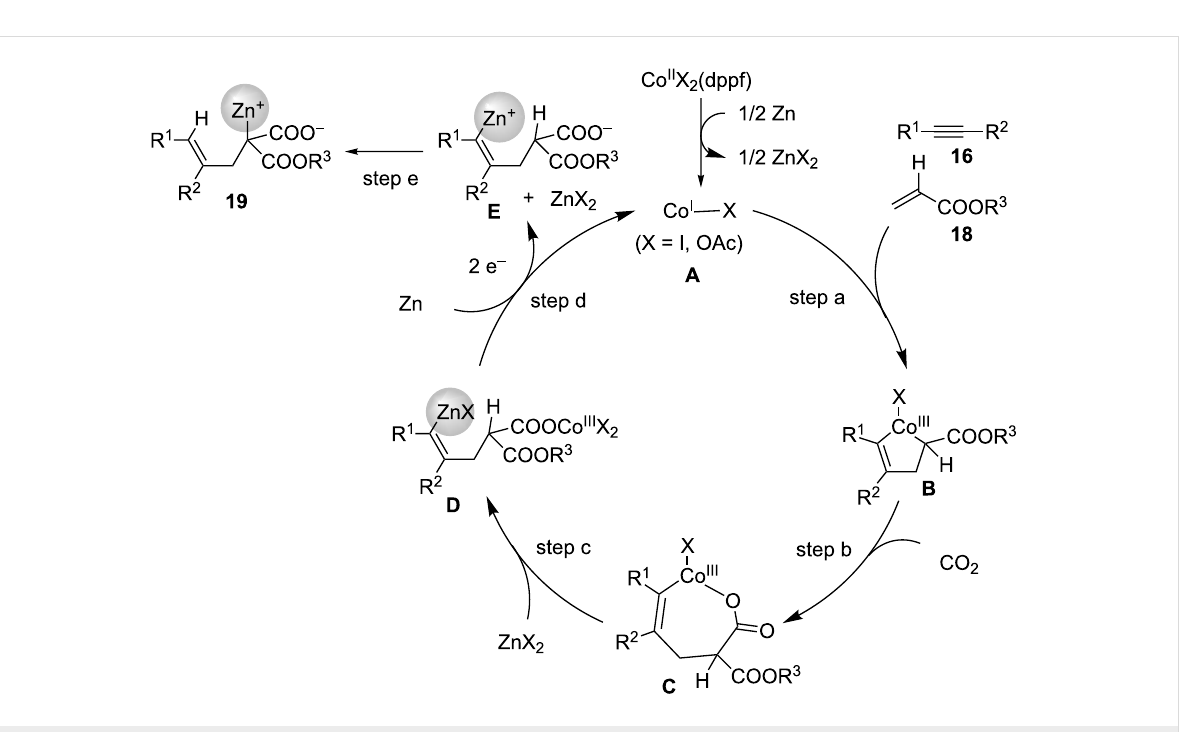
Scheme 19: Proposed reaction mechanism for the Co-catalyzed four-component